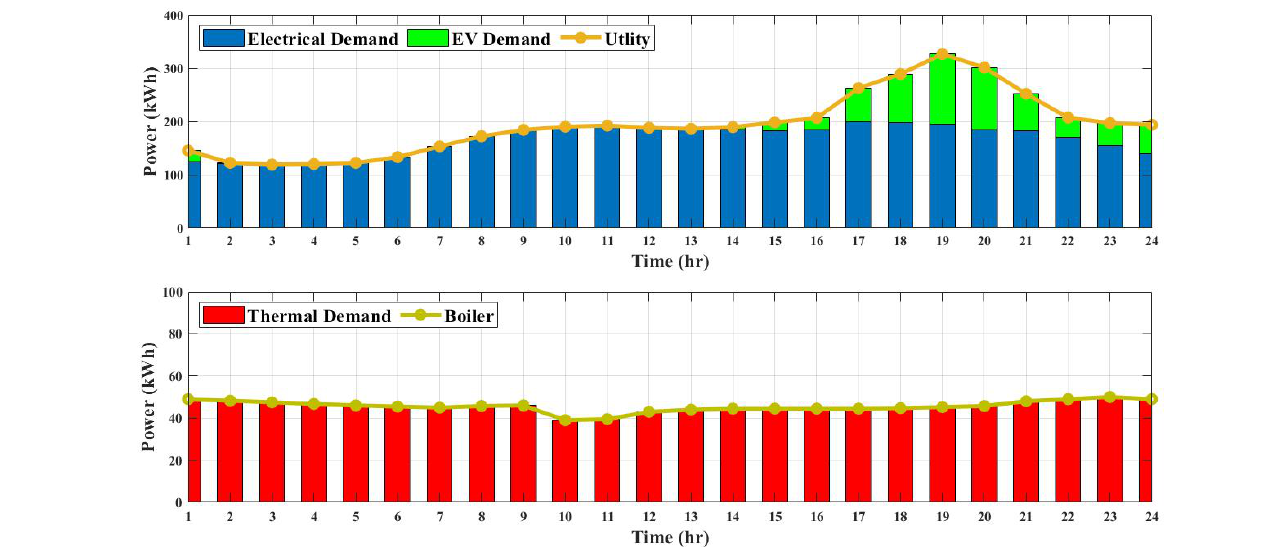
Figure 10. Base Case mode of house.